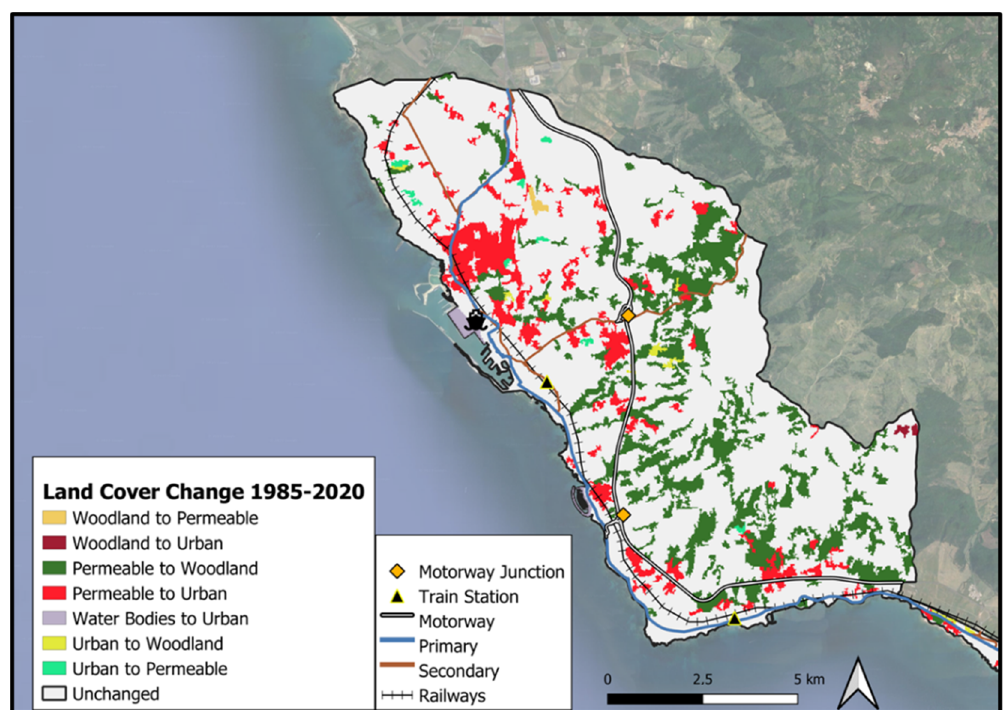
Figure 9. Variation and dynamics of LC within the Civitavecchia and Santa Marinella municipalities for the total time span (1985 ÷ 2020), sieved image at a threshold of 10 pixels, 4-bit connectivity.